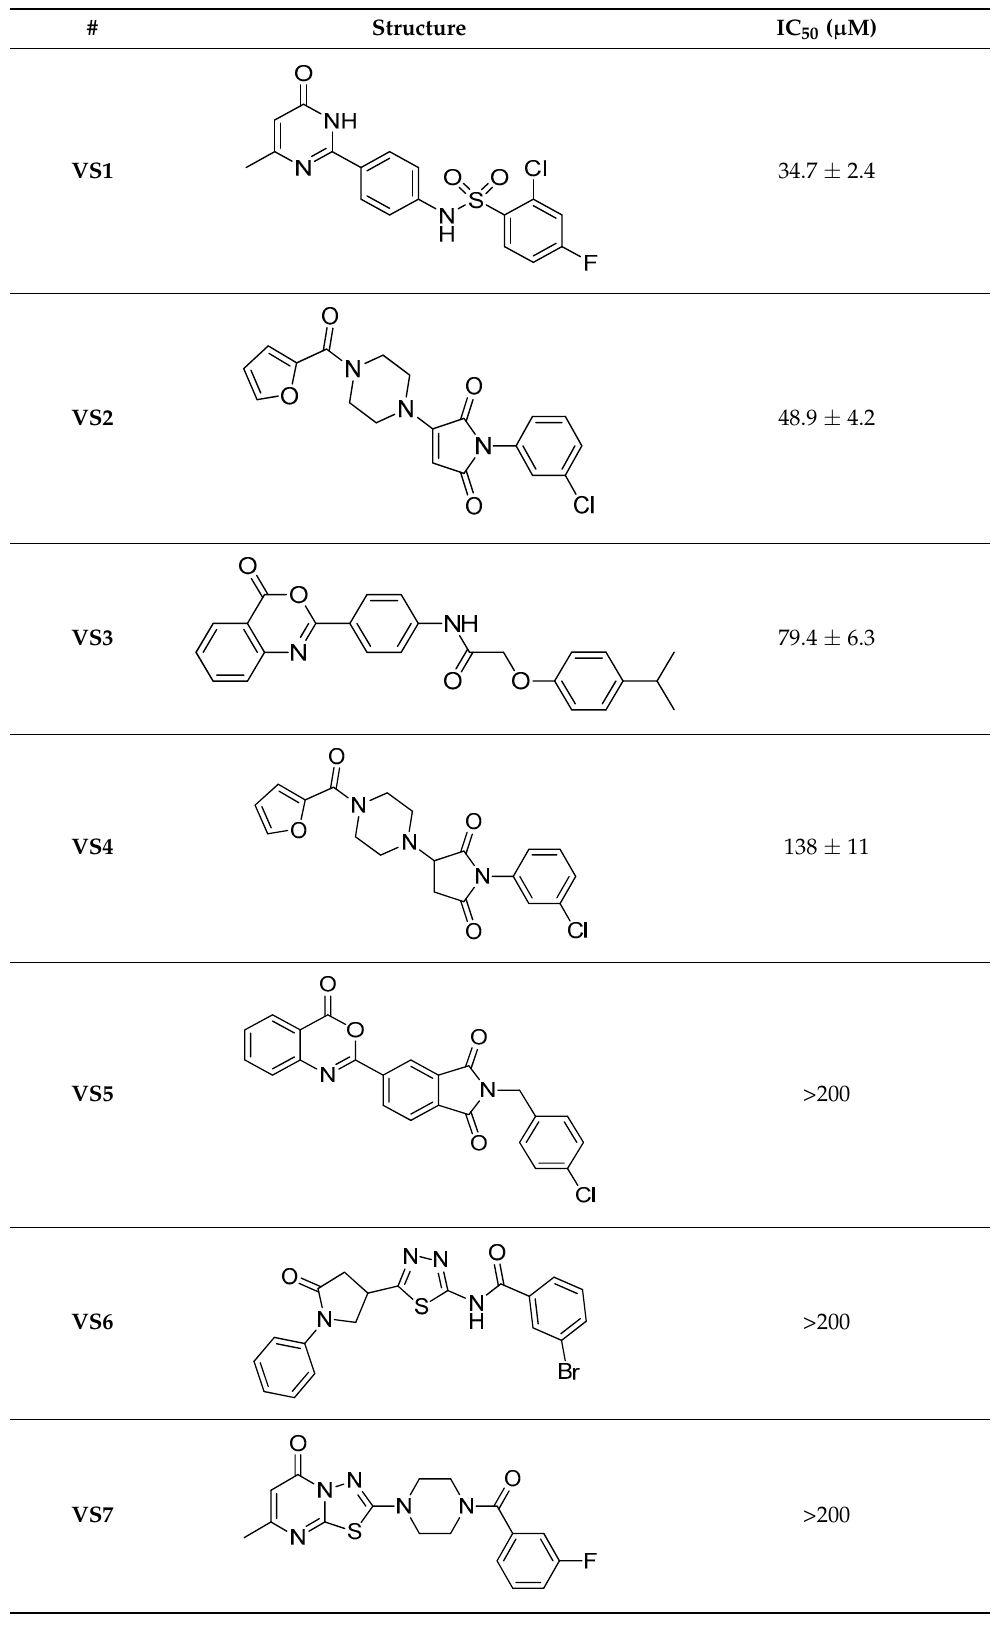
Table 3. Structure and MAGL inhibition activity of the tested compounds. Compound 17b [19] and compound 3l [16] were used as reference compounds.